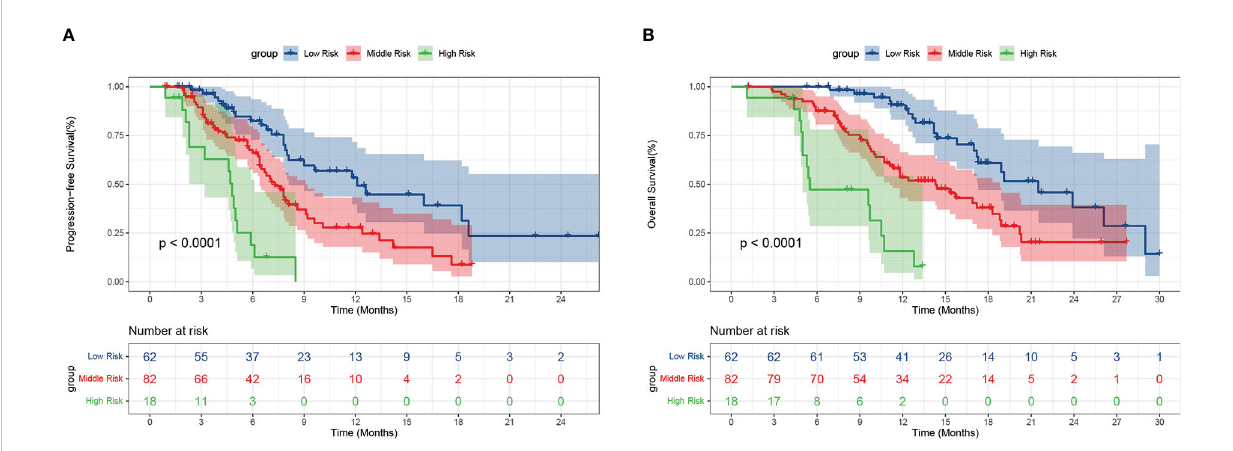
FIGURE 6 Progression-free survival (A) and overall survival (B) of patients with different risks. Low risk: score of 0, Middle risk: score of 1 or 2, High risk: score of 3 or